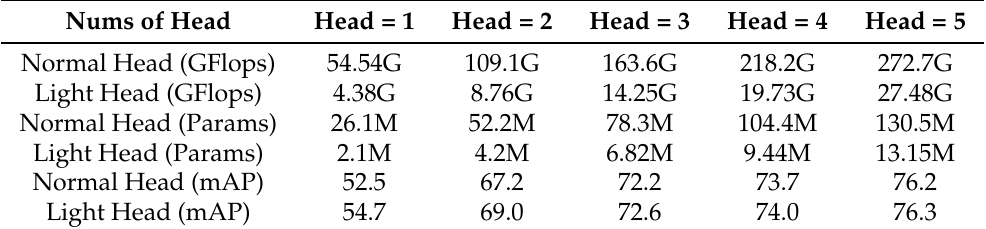
Table 6. Analysis of Light Head’s computation and parameter amount under multiple detec- tion